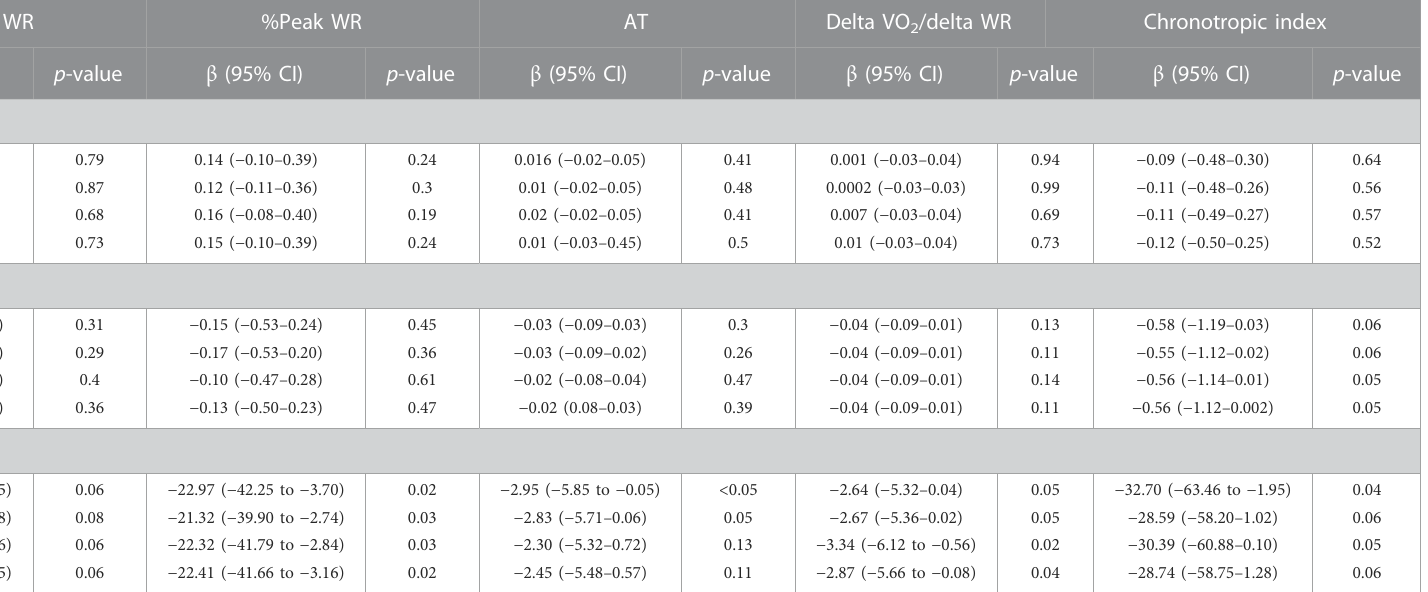
TABLE 7 Multiple linear regression analysis determine the association of carnitine pro fi le with secondary